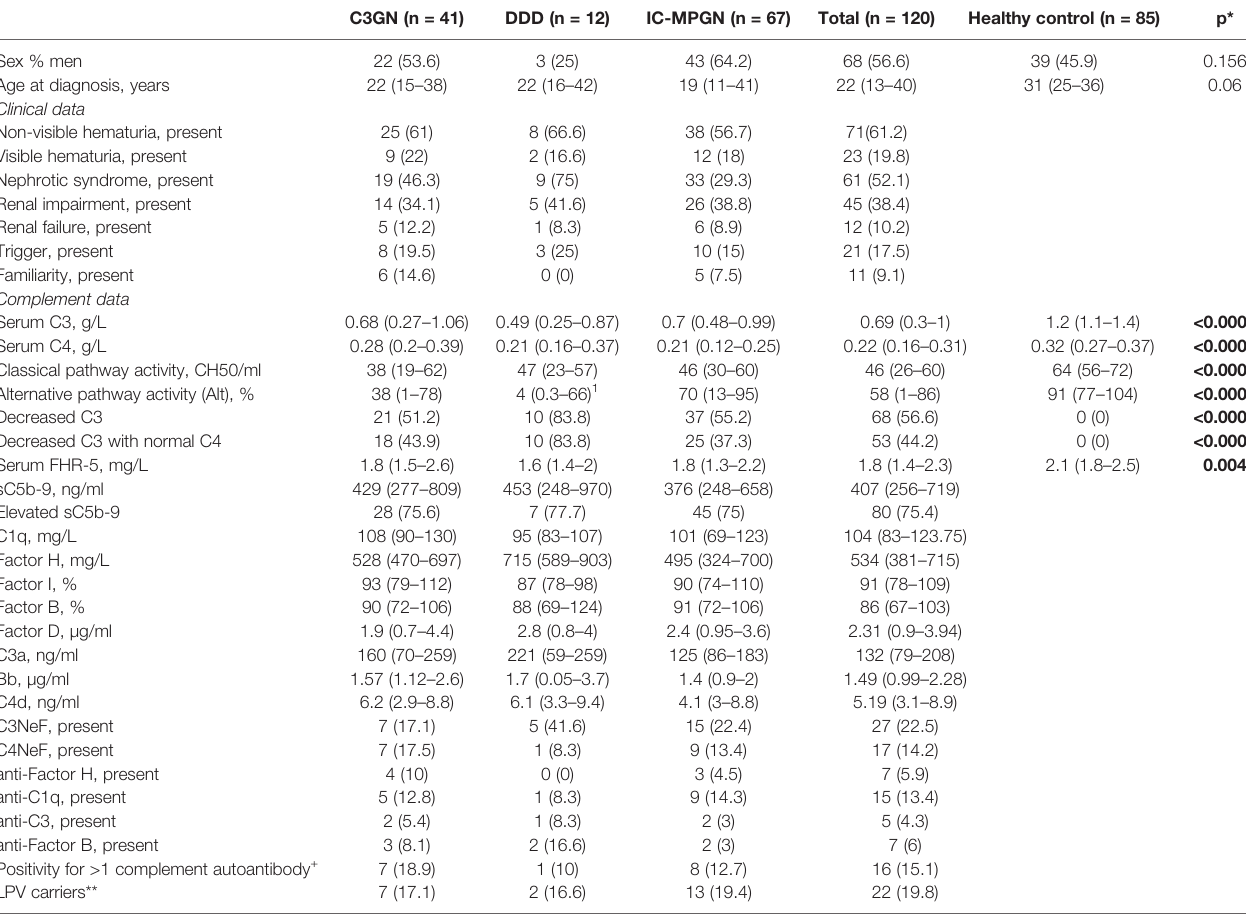
TABLE 1 | Clinical characteristics of patients with